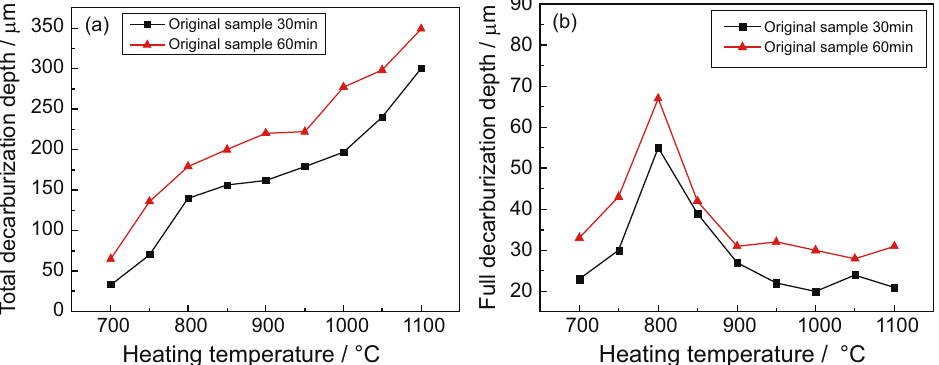
Figure 3: Decarburization depth variation of steel at di ff erent heating temperatures: ( a ) total and ( b ) full